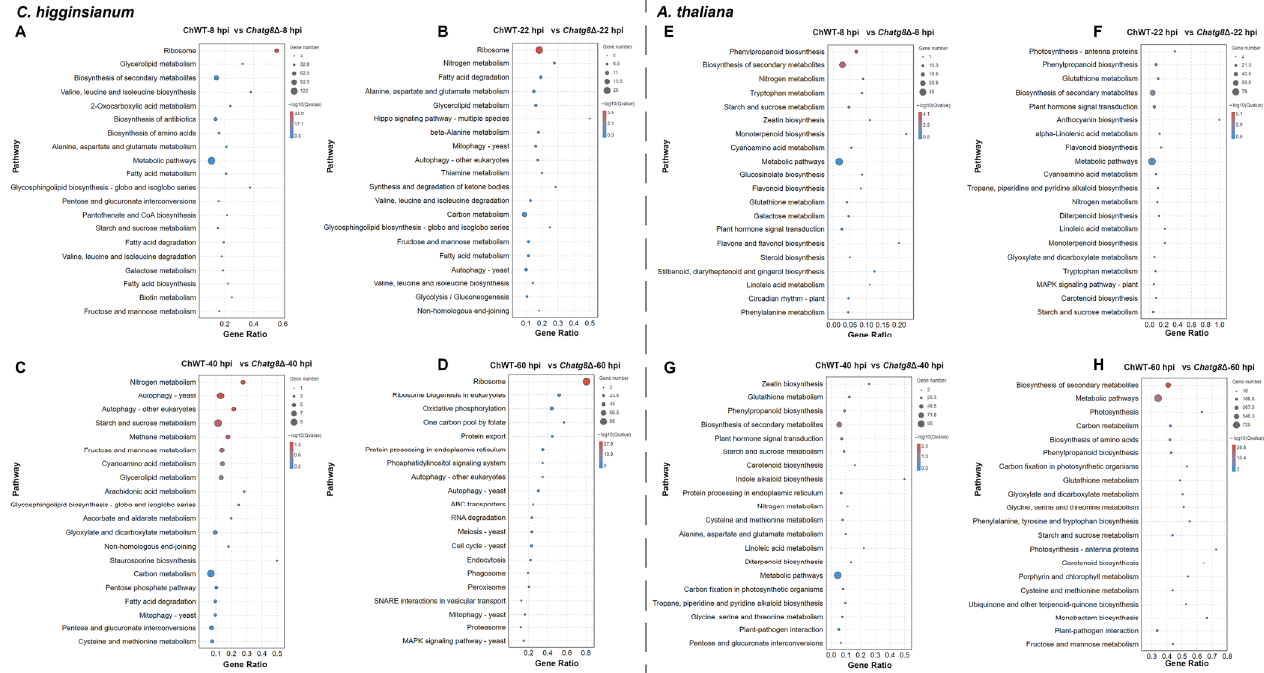
Figure 4. KEGG pathway classification of the DEGs in the four comparison groups. ( A , E ) ChWT-8 hpi vs. Chatg8 Δ-8 hpi in C. higginsianum or A. thaliana . ( B , F ) ChWT-22 hpi vs. Chatg8 Δ-22 hpi in C. higginsianum or A. thaliana . ( C , G ) ChWT-40 hpi vs. Chatg8 Δ-40 hpi in C. higginsianum or A. thaliana . ( D , H ) ChWT-60 hpi vs. Chatg8 Δ-60 hpi in C. higginsianum or A. thaliana . Gene ratio refers to the ratio of the number of genes associated with a KEGG pathway to the total number of DEGs and the size of the dots refers to the number of DEGs in each KEGG pathway.